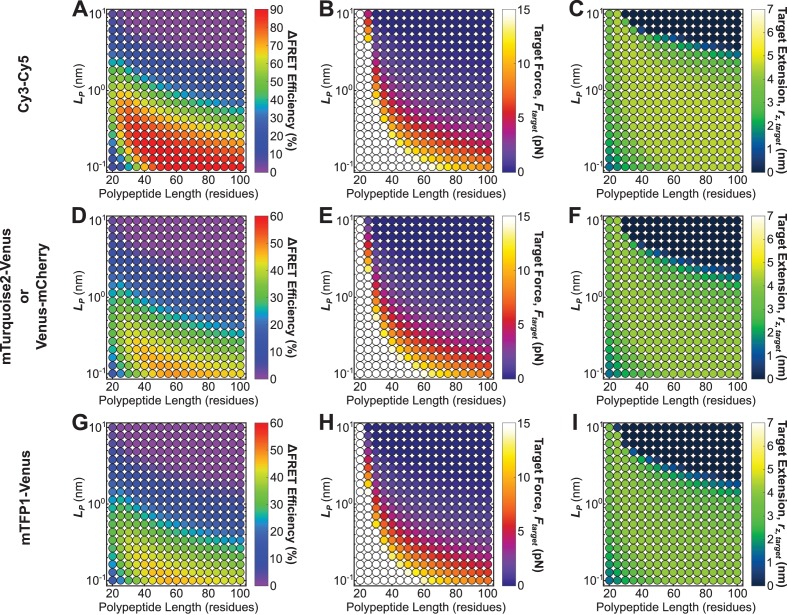
Roadmaps to guide the rational design of FRET-based molecular tension sensors for some commonly used FRET-pairs.Parameter space highlighting the predicted ΔFRET at the 5% FRET noise floor (A, D, G), as well as corresponding target force, Ftarget (B, E, H), and target extensions rz,target (C, F, I), for a variety of Cy3-Cy5 (A-C), Venus-mCherry or mTurquoise2-Venus (which have identical R0) (D-F), and mTFP1-Venus (G-I), based sensors with a variety of polypeptide lengths (x-axis), and mechanical properties (y-axis). Each point represents a single potential tension sensor design.